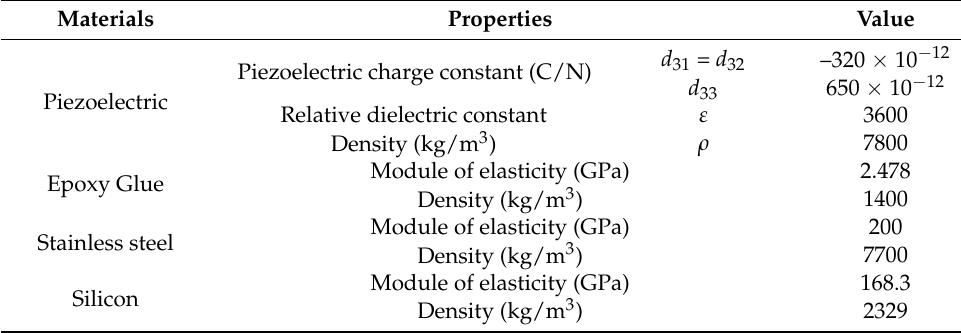
Figure 1. Schematic diagram of blood sampling device, ( a ) design of wristwatch with micropumps, and ( b ) detail represen- tation of a piezoelectric micropump with FQPB actuator. Table 1. Mechanical properties of materials.